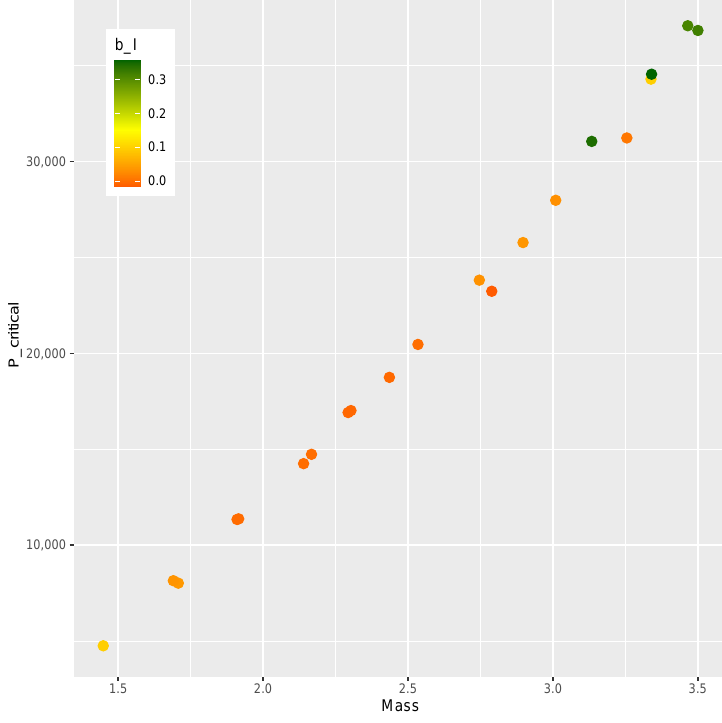
Figure 19. Mass m and P critical at critical